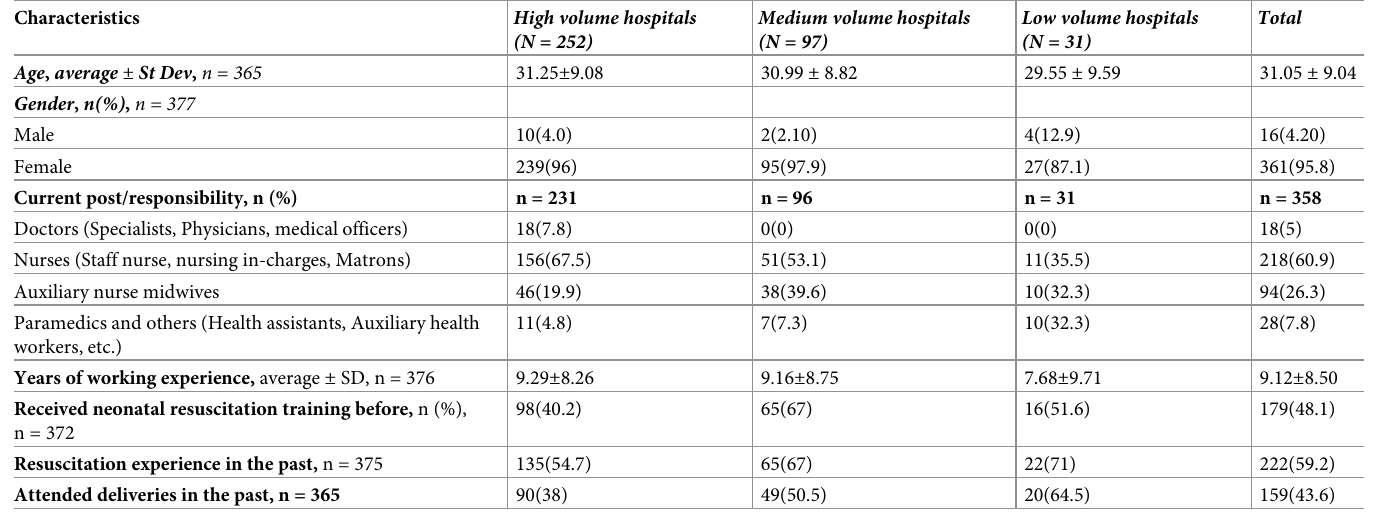
Table 1. Background characteristics of the training participants by the size of hospitals.